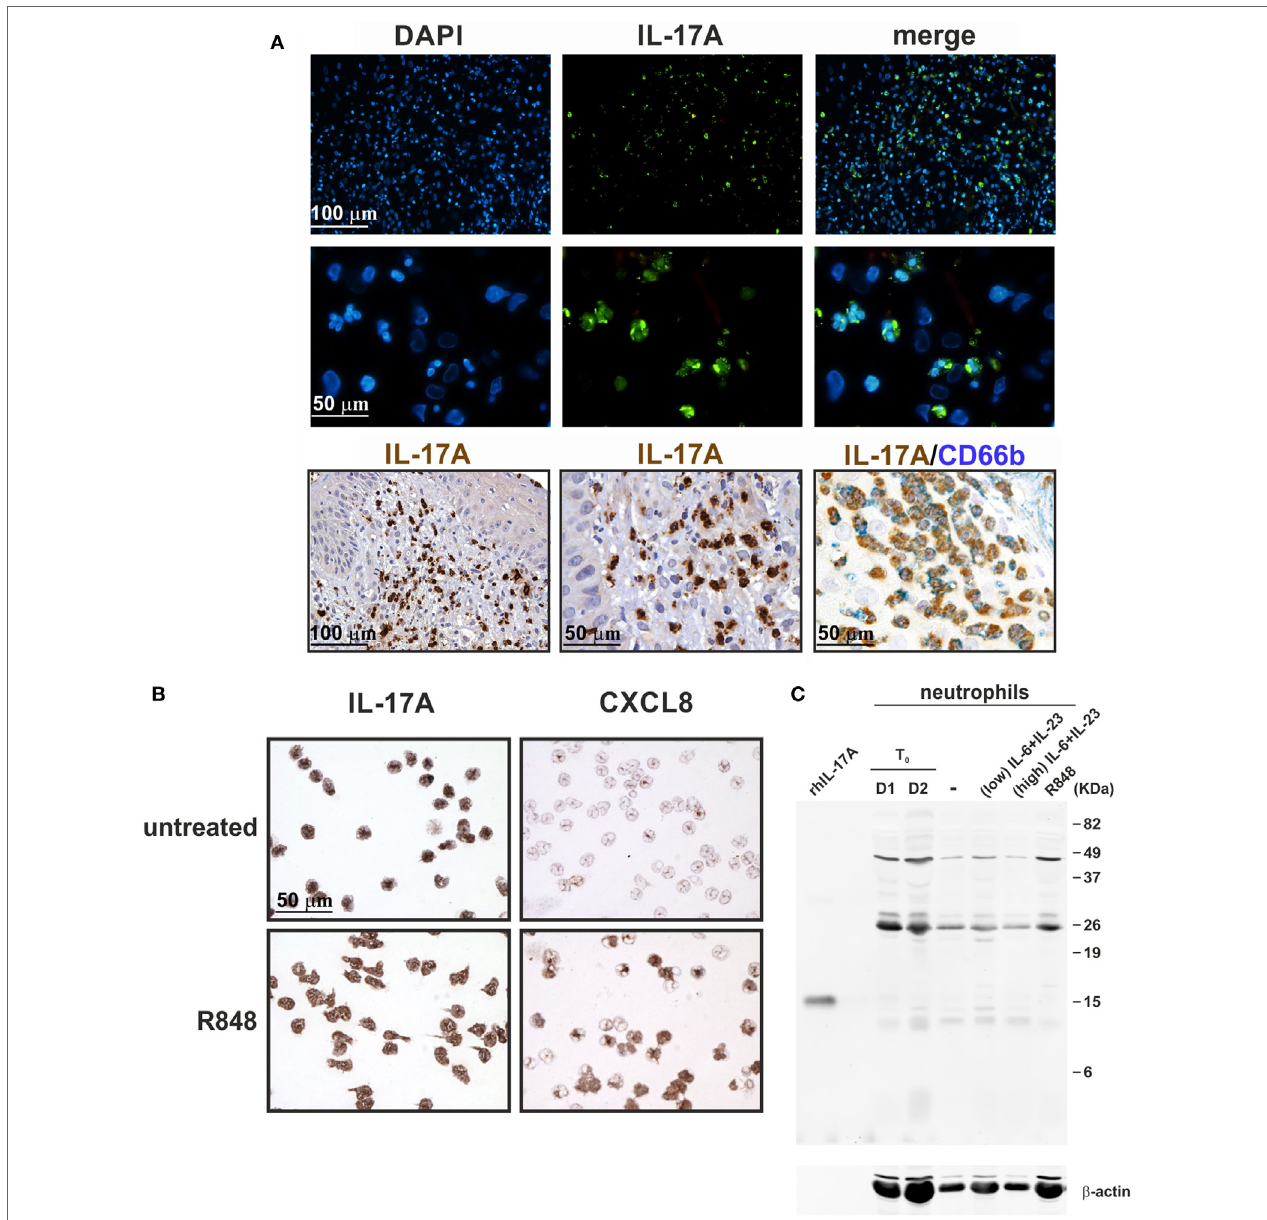
FigUre 8 | Staining human neutrophils by anti-IL-17A (AF-317-NA) polyclonal antibodies (Abs). (a) Immunofluorescence (top panels) and immunohistochemistry (lower panels) stainings of two FFPE cases of human pustular psoriasis using anti-IL-17A (AF-317-NA) and anti-CD66b Abs (as labeled). Top panels show DAPI, FITC channel, and merge to recognize neutrophil shape; lower panels show different magnification of IHC and double IHC to characterize IL-17A + cells with the neutrophil marker CD66b. (B) Cytospins of neutrophils, either untreated (top panels) or treated with 5 µM R848 (bottom panels) for 3 h, were stained with anti-IL-17A (AF-317-NA, left panels) and anti-CXCL8 (right panels) Abs. Original magnification 200 × [first row in (a) and left image in third row, scale bar 100 µm] and 400 × [second row in (a) , center/right images in third row in (a) , as well as in (B) , scale bar 50 µm]. Images of the second row in (a) represent magnifications of images in first row. (c) AF-317-NA immunoblot of lysates from neutrophils either freshly isolated (T 0 , from two donors) or incubated for 3 h with or without 2 µg/ml IL-6 plus 0.2 µg/ml IL-23 (low), 20 µg/ml IL-6 plus 2 µg/ml IL-23 (high), or 5 µM R848. Recombinant human IL-17A (rhIL-17A) was used as positive control. Panels (B,c) display representative experiments out of two independent ones with similar